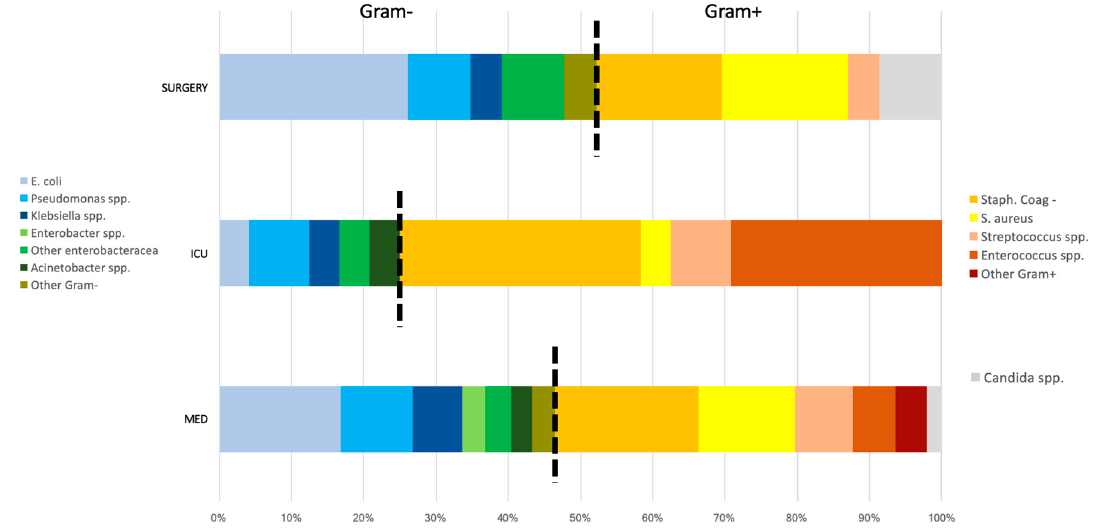
Figure 2. Distribution of BSI isolates in the different hospital wards according to Gram stain.